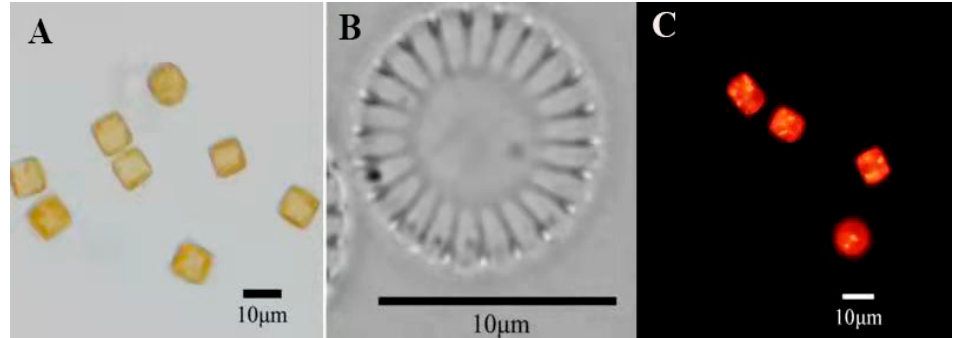
Figure 1. Cyclotella menegheniana MH2018001 (( A , B ) light micrographs; ( C ) fluorescence